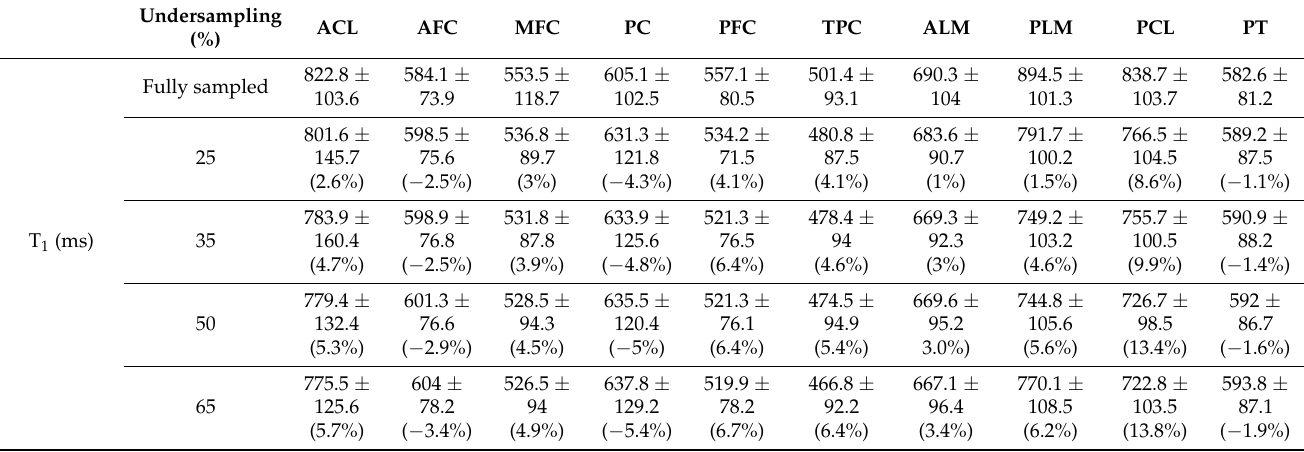
Table 3. Parameter quantification for 10 ROIs with mean and standard deviation along with